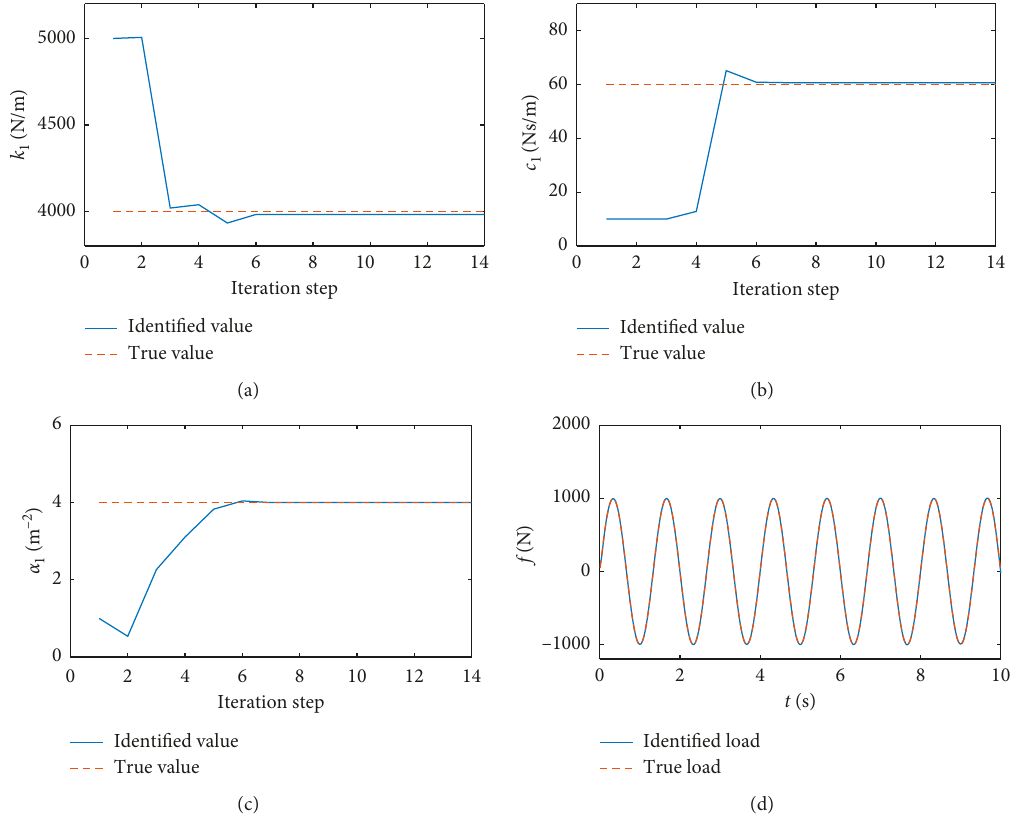
Figure 3: The convergence processes of (a) k regularization parameter.